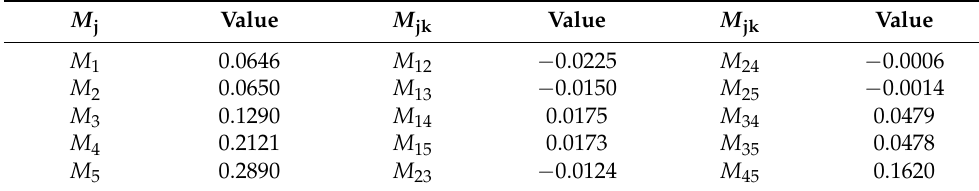
Table 9. Values of Mobius representation.